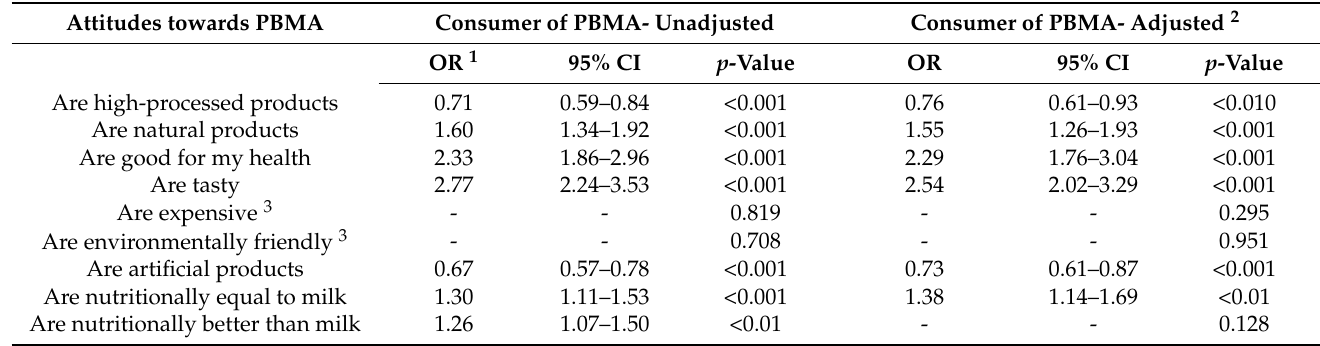
Table 4. Likelihood of being a consumer of PBD by attitudes towards PBMA.